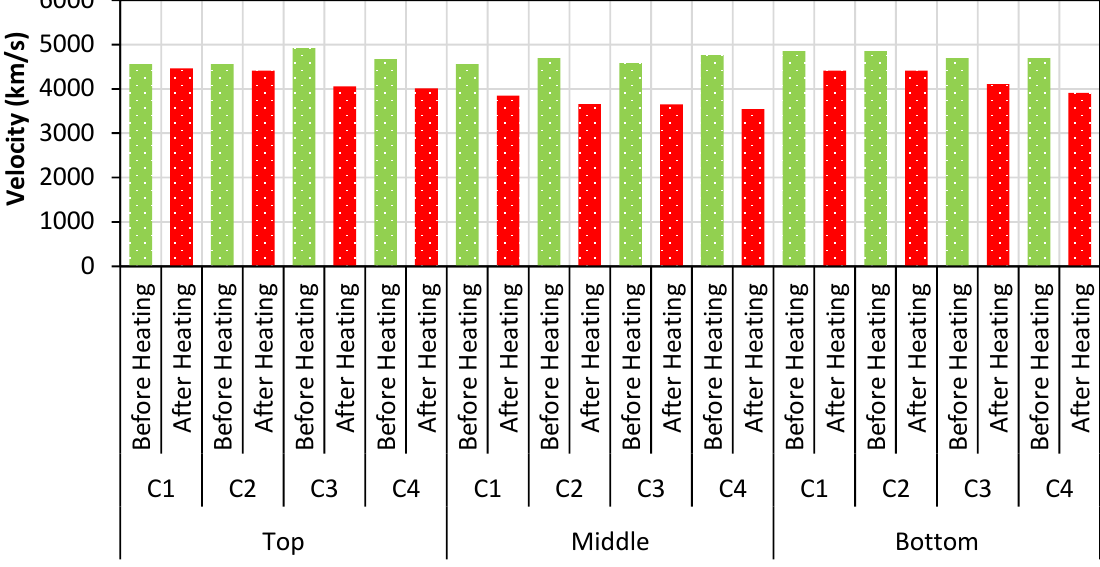
Figure 22. Postfire images of the specimens.